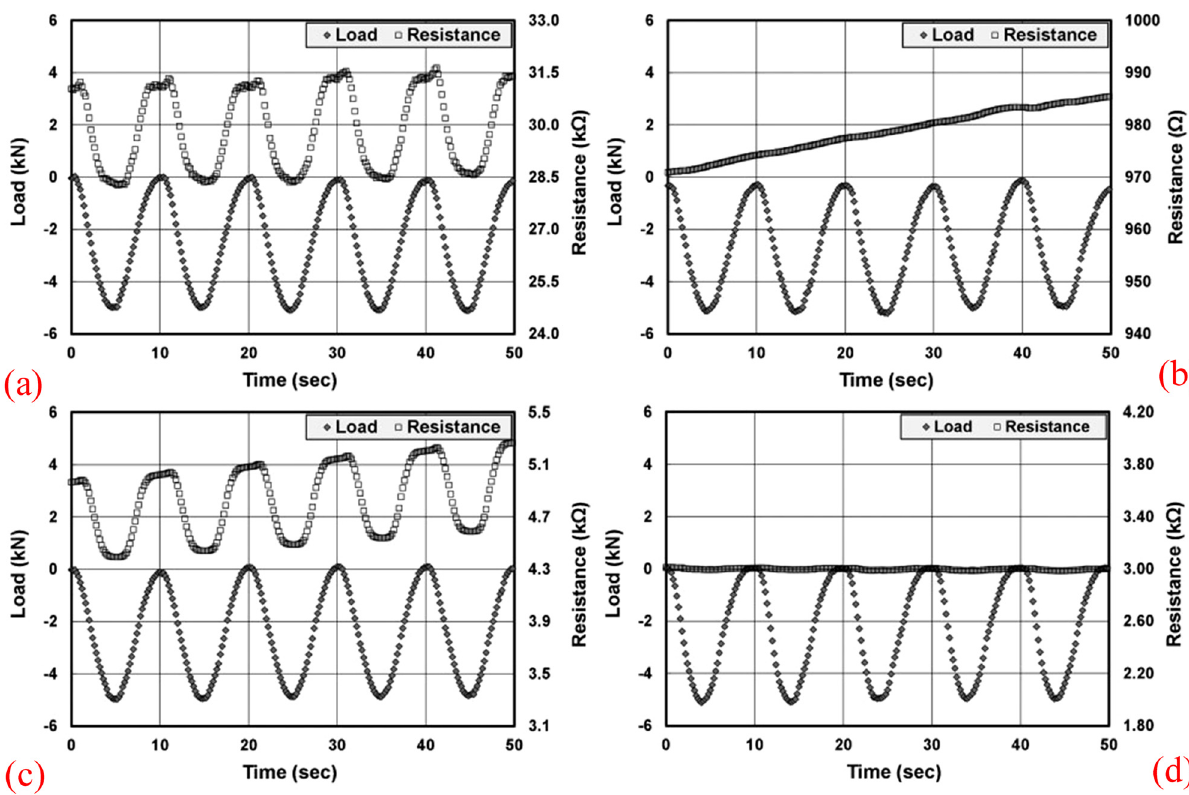
Figure 3: Piezoresistive response of CNTCS at di ff erent humidity: ( a ) dry curing – no drying – CNT, ( b ) wet curing – no drying – CNT, ( c ) wet curing – drying – CNT, and ( d ) dry curing – no drying – without CNT [ 40 ] .